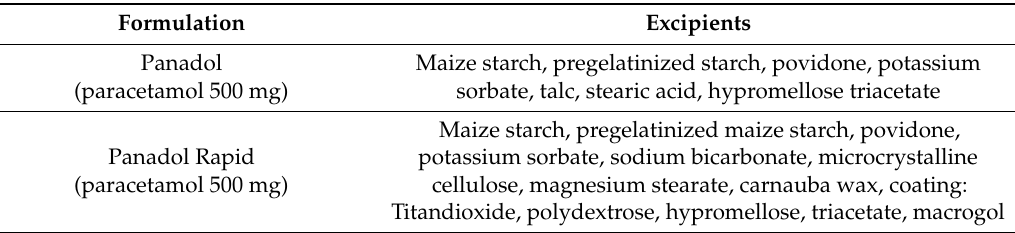
Table 1. Excipients in Panadol and Panadol Rapid. Formulation